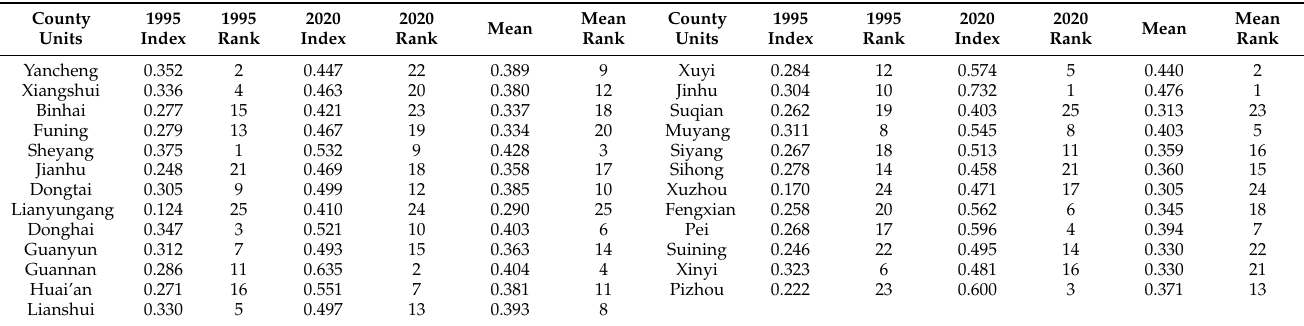
Table 2. Index and ranking of recessive cultivated land use